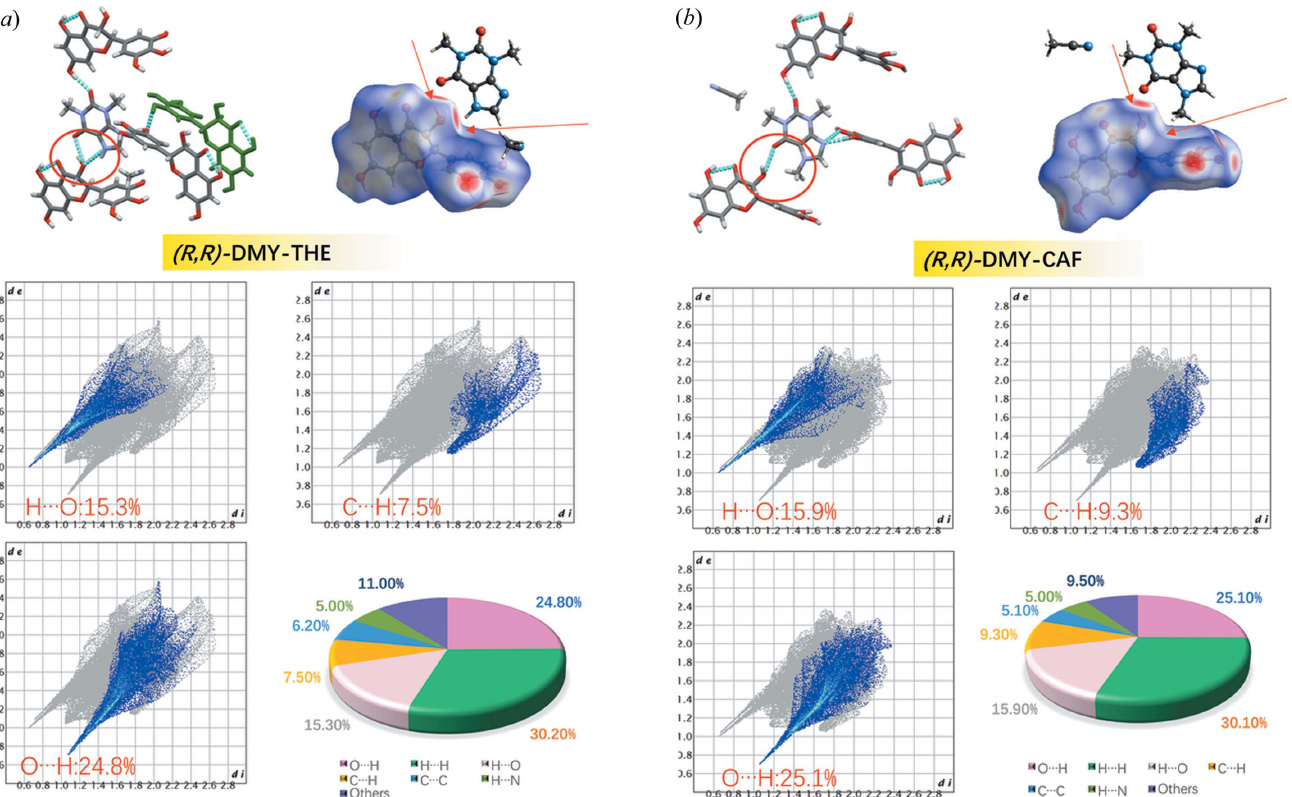
Figure 12 Comparisons of intermolecular interactions of R , R -DMY–THE and R , R -DMY–CAF cocrystals with HS and 2D fingerprint plots based on the d norm value and the percentage contributions to the